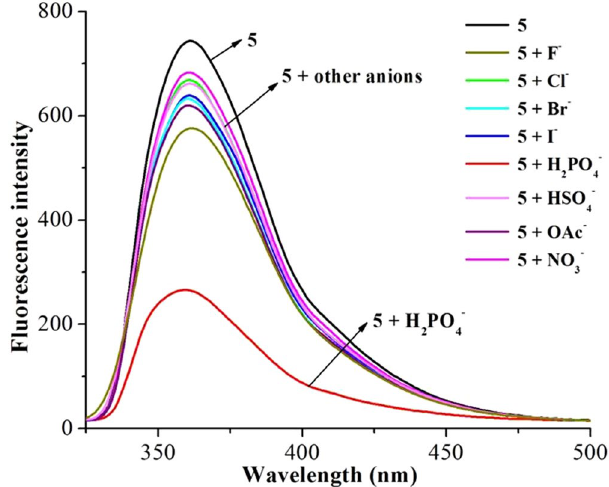
Figure 9. Fluorescence spectra of 5 (1 × 10 − 5 mol/L) and upon the addition of salts (20.0 equiv) of F − , Cl − , Br − , I − , H 2 PO 4 − , HSO 4 − , OAc − and NO 3 − in CH 3 CN at 25 °C.